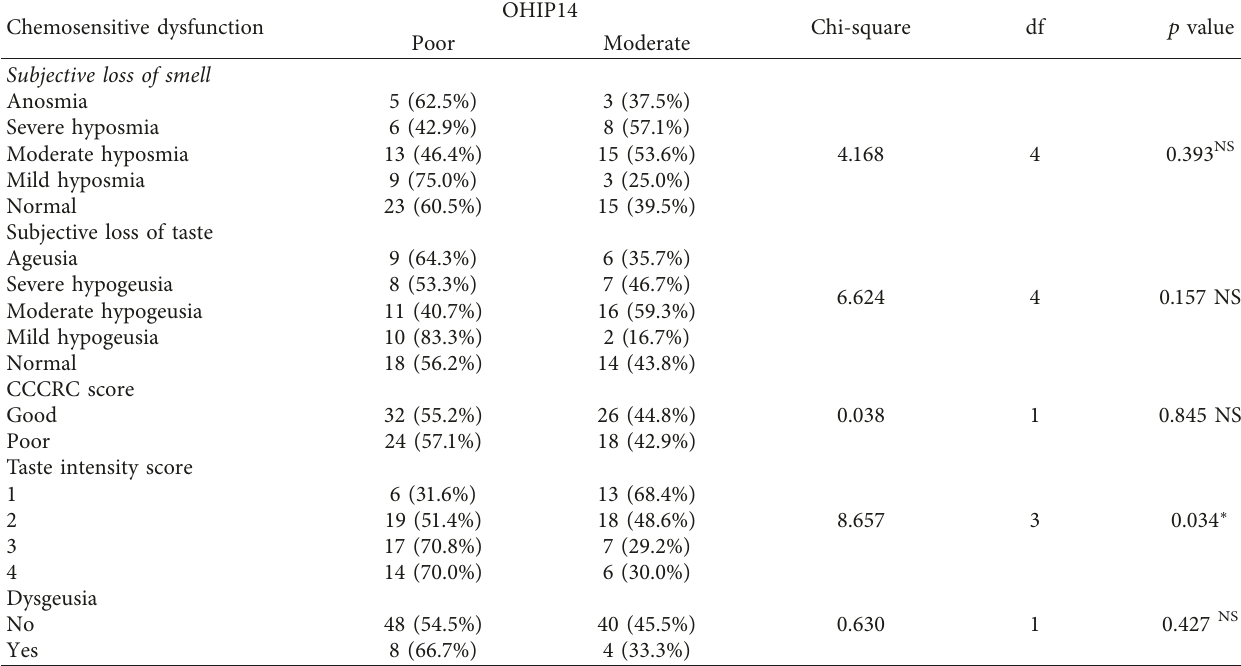
Table 5: Chi-square test of association between OHIP14 (oral health index profile) and chronic chemosensitive dysfunction in post- COVID-19 patients (fishers exact